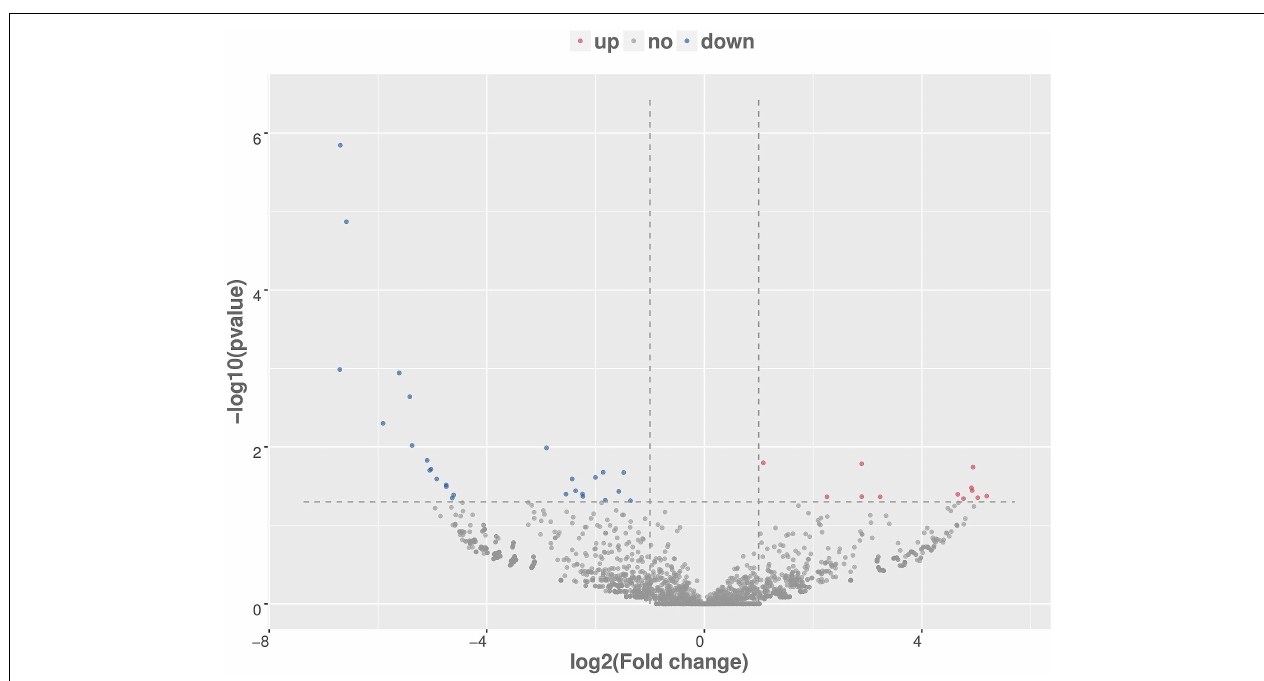
FIGURE 9 | Differentially expressed circRNA volcanic map, with log2 (fold-change) as the abscissa, –log10 ( p -value) as the ordinate. Red, blue, and gray are representative the upregulated, downregulated, and unchanged circRNAs, respectively.